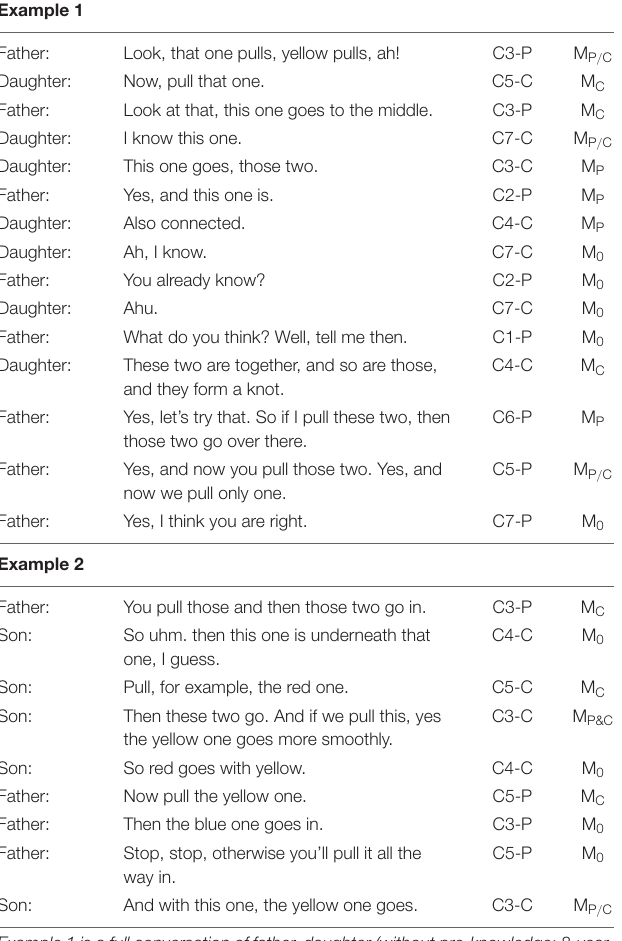
TABLE 3 | Two examples of parent–child conversations during inquiry at a black-box. Example